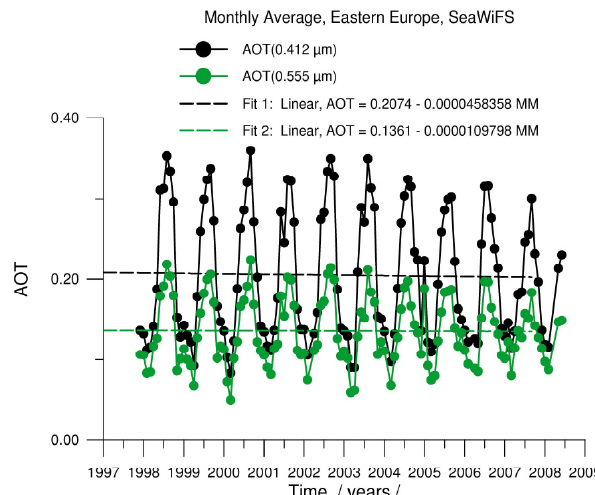
Fig. 22c. Eastern Europe.